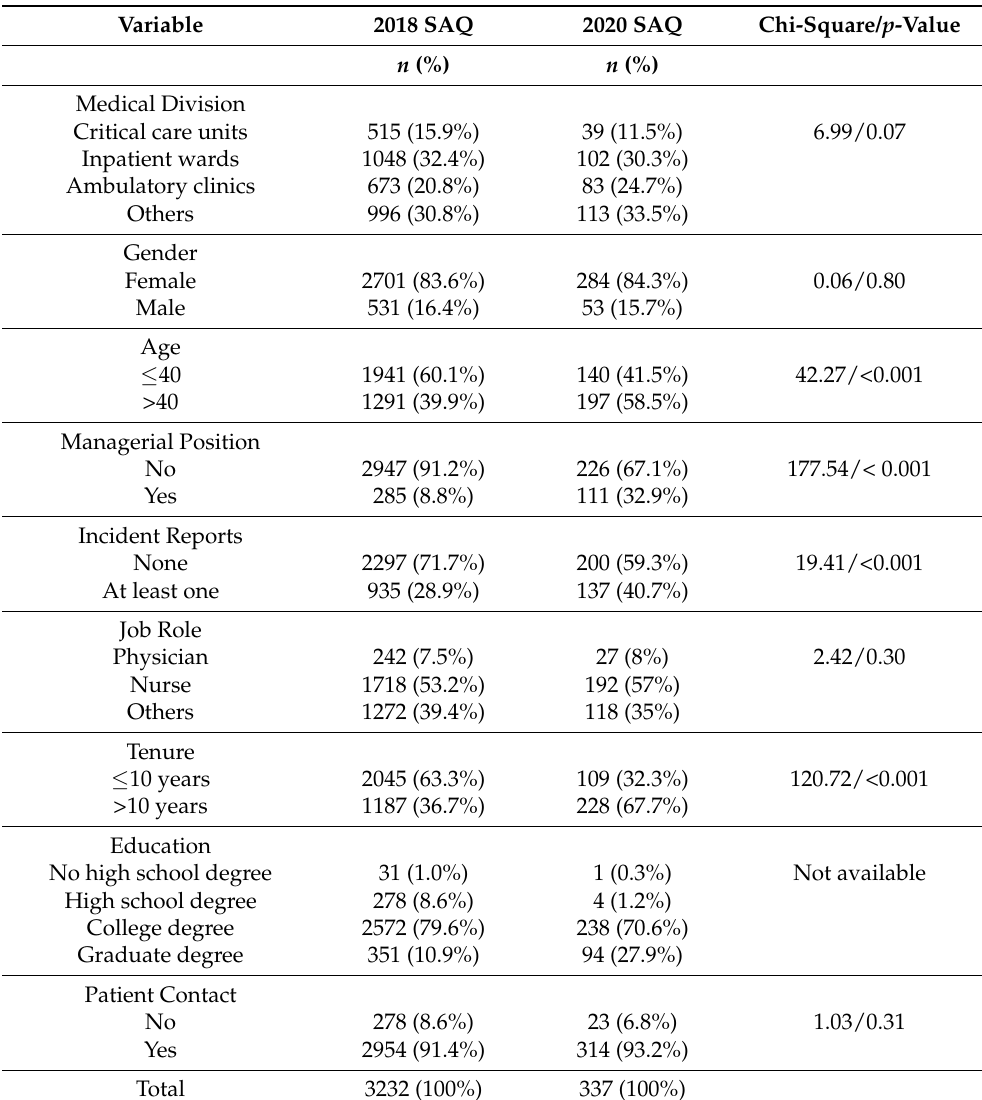
Table 1. Respondent